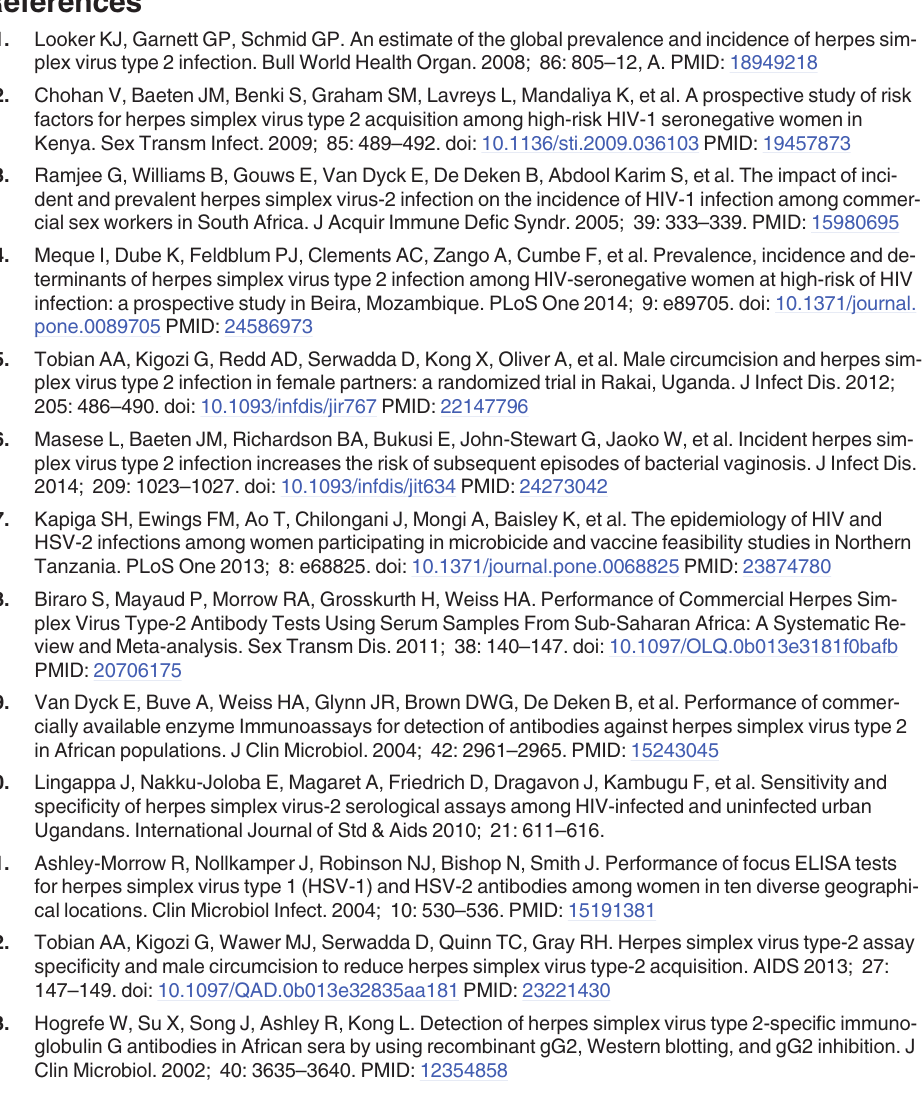
S1 Table. Time of seroconversion for HerpeSelect and Kalon assay using manufacturer ’ s cut-off and lowered